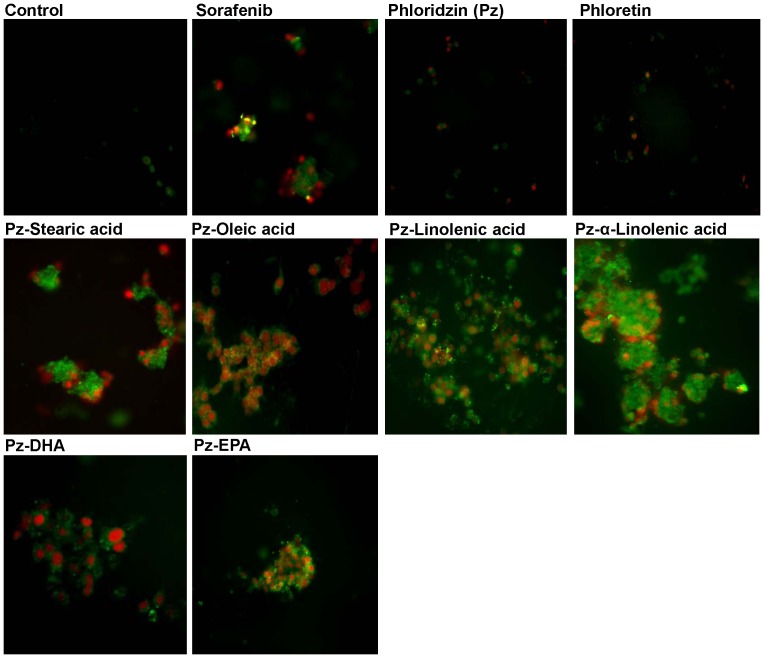
Fluorescent microscopic analysis of apoptotic HepG-2 cells stained with Annexin V-FITC and 7-AAD.The cells were cultures (1×105 cells) in chambered slides and incubated with 100 µM of fatty acid esters of phloridzin (Pz) in comparison with parent compounds phloridzin or phloretin (aglycone) or liver cancer drug sorafenib. Green and red color indicates early and late apoptotic cells, respectively. Shown are representative images of three independent experiments.